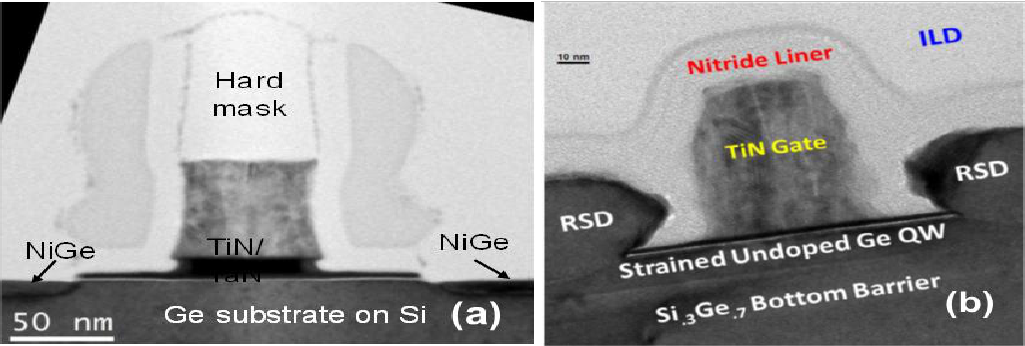
Figure 13. Transfer characteristics of measured ( a ) 65 nm Ge pMOSFET at low and high IEEE; ( b ) 100 nm Ge pQWFET at VDS = −0.05 V (open circle) and −0.5 V (solid